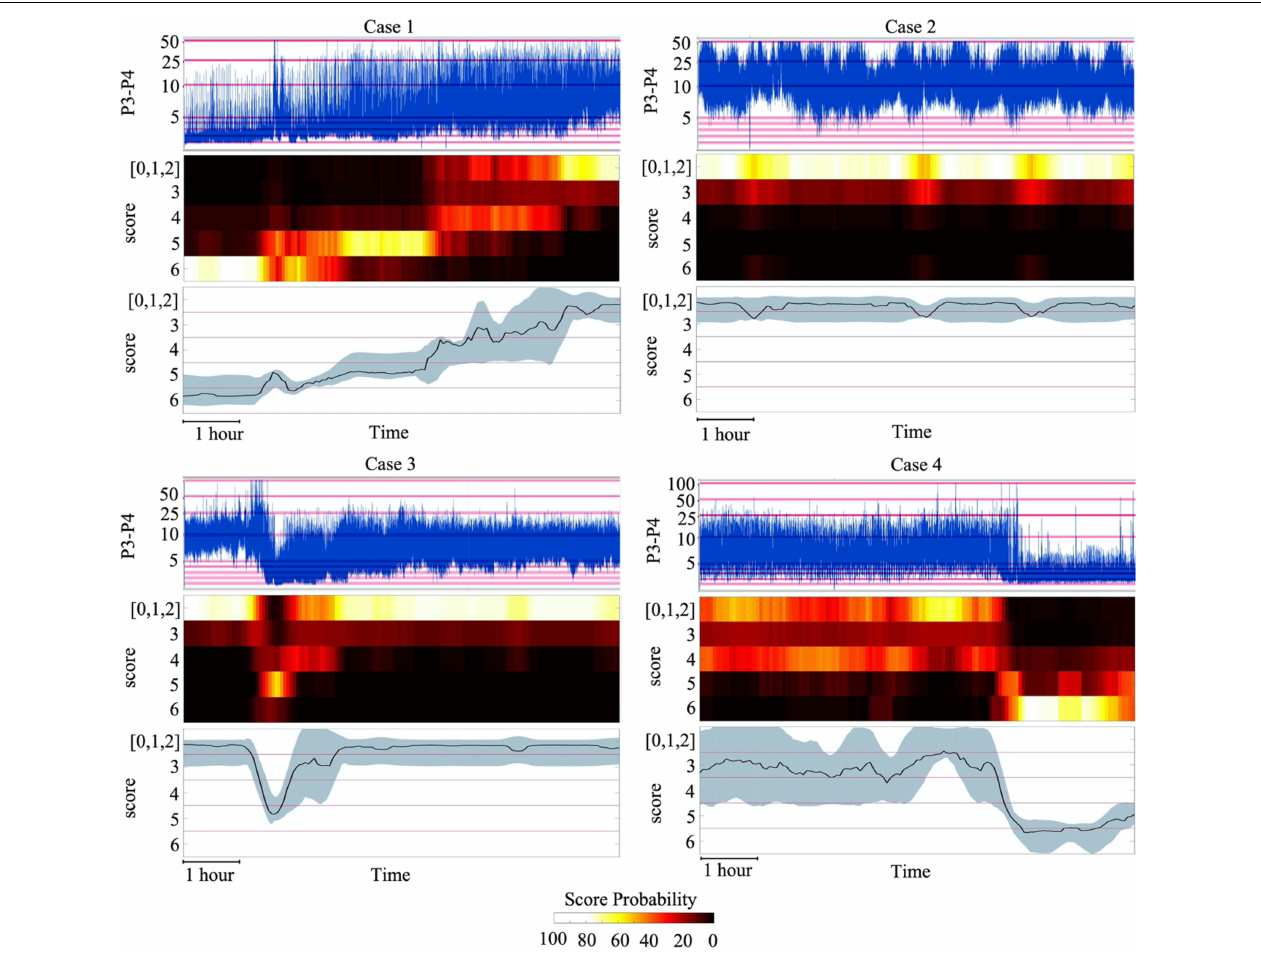
FIGURE 8 | Visualization of SVM classifier outputs and its comparison to the aEEG trend display using an unseen EEG monitoring data. The colours in the heatmap visualisation indicate the probability of the given score (normalized over all scores at each 5 min epoch). Note the overall match in the temporal evolution of brain activity seen in both the aEEG trend and the classifier outputs. In BT visualisation, the classifier output is converted to a unidimensional score that depicts the likeliest score and its confidence, showing how the real evolution of brain activity goes through non-discrete transition toward better